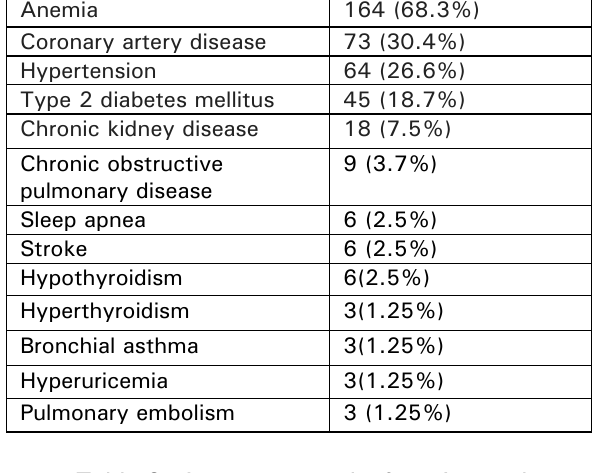
Table 3. Acute organs dysfunction and